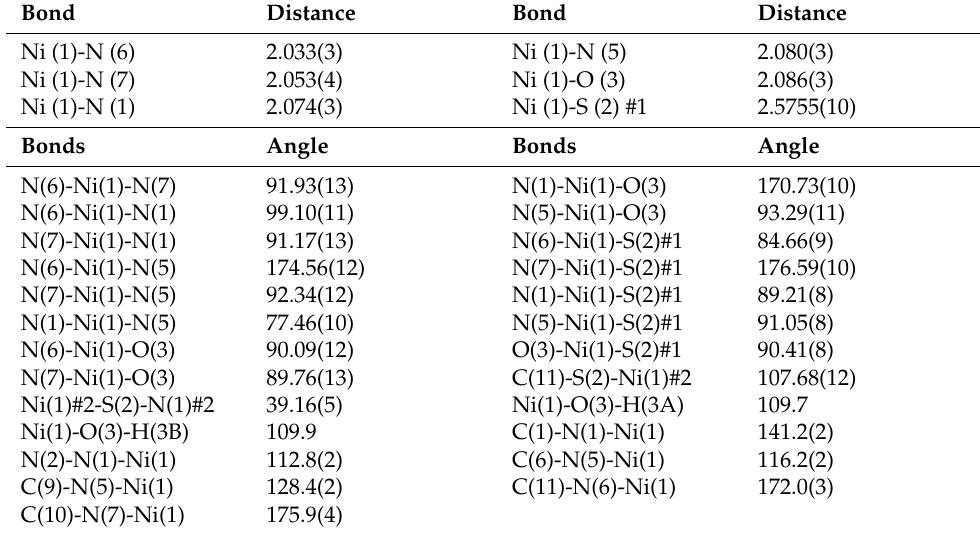
Table 2. The most important bond distances and angles in the [Ni (MPT)(H 2 O)(SCN) 2 ] n complex. Bond